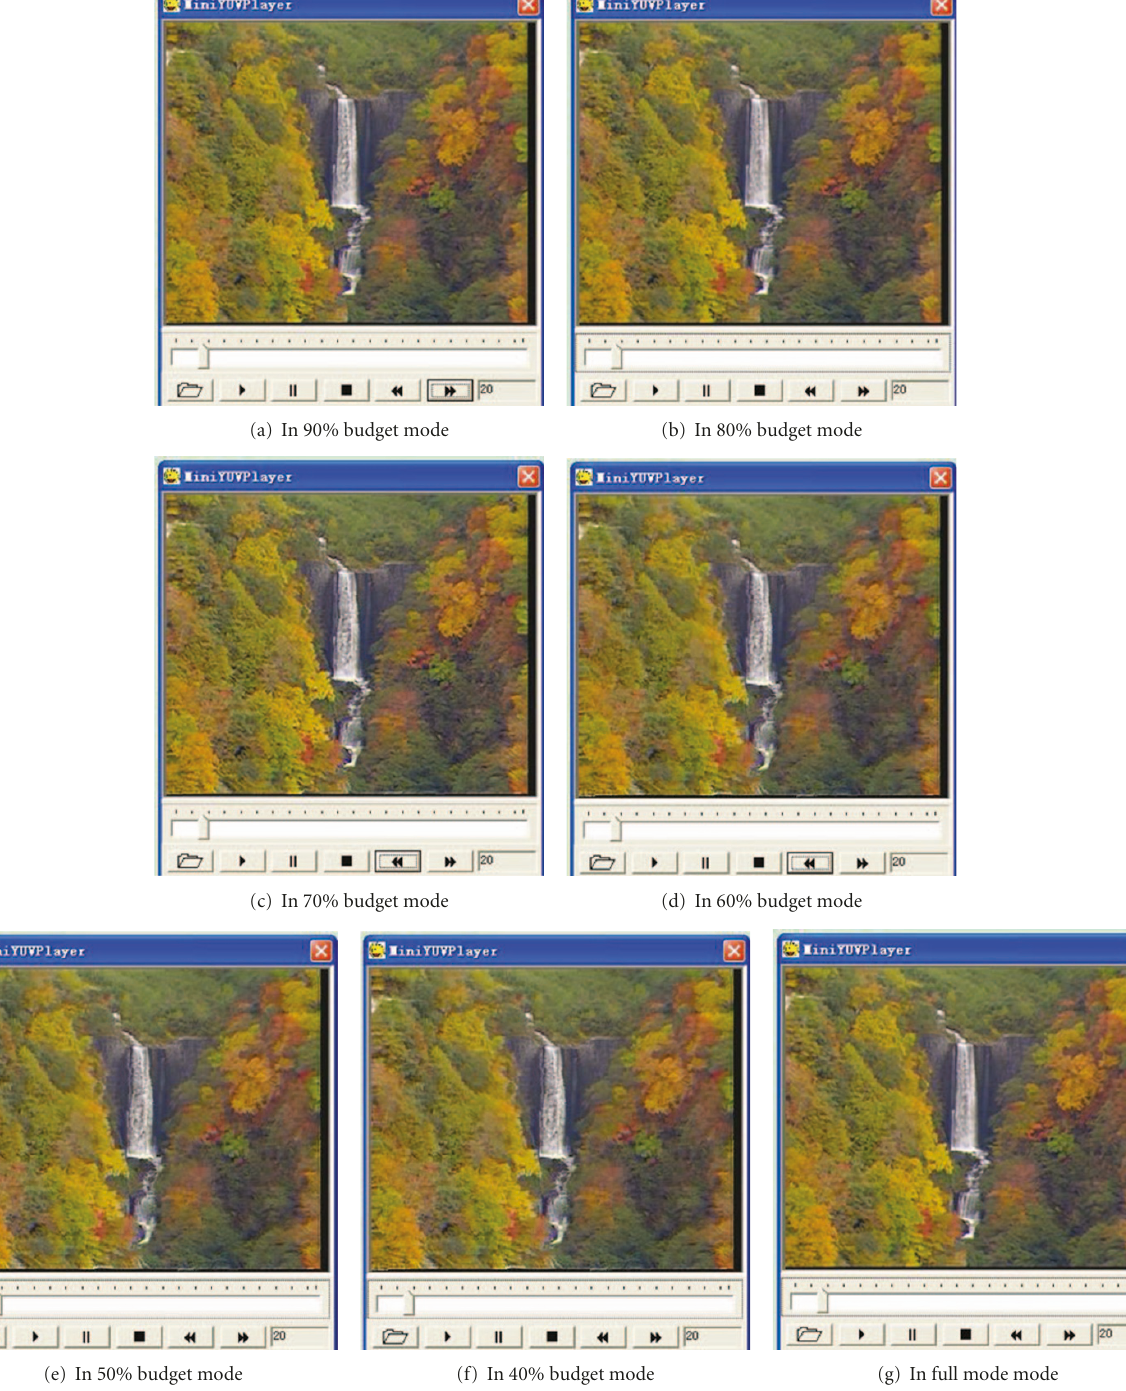
Figure 8: Subjective quality in the di ff erent scalable